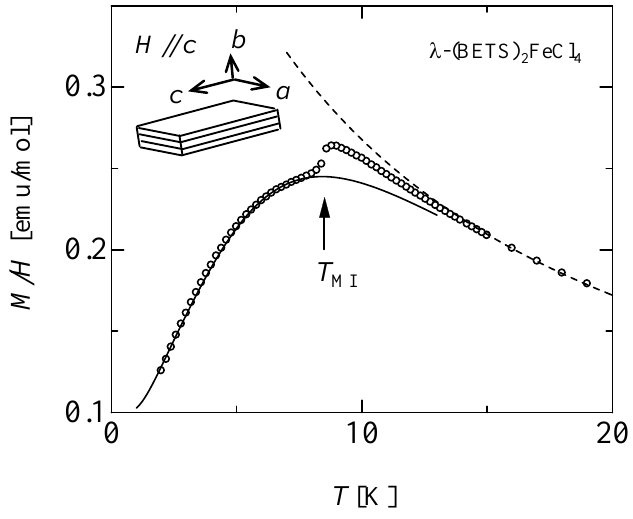
Figure 4. Magnetic susceptibility M / H of λ-BETS parallel to the c -axis. The solid and dashed curves show the magnetic susceptibility calculated on the basis of the paramagnetic 3 d spin model and Curie–Weiss law, respectively. Reproduced with permission from JPSJ